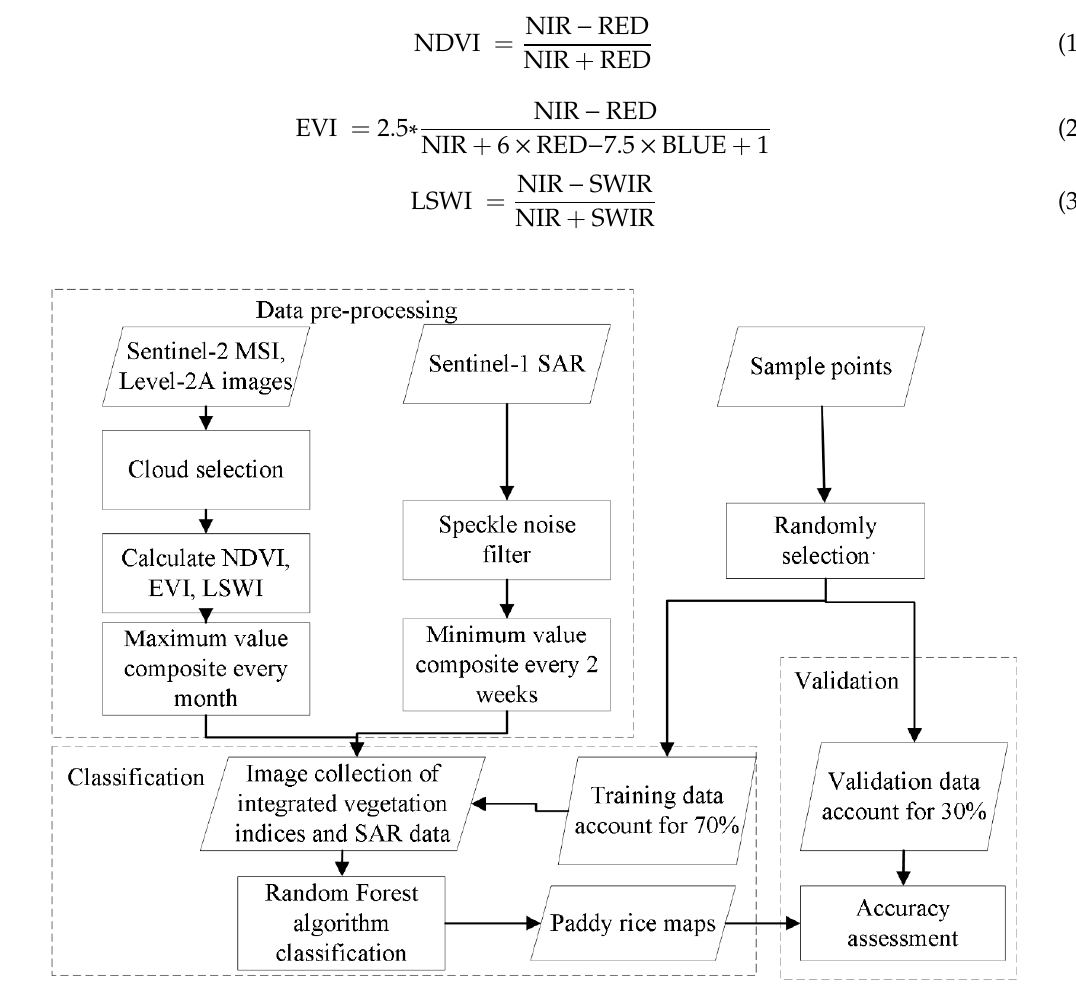
Figure 2. Framework for combining SAR and vegetation indices data for paddy rice mapping.